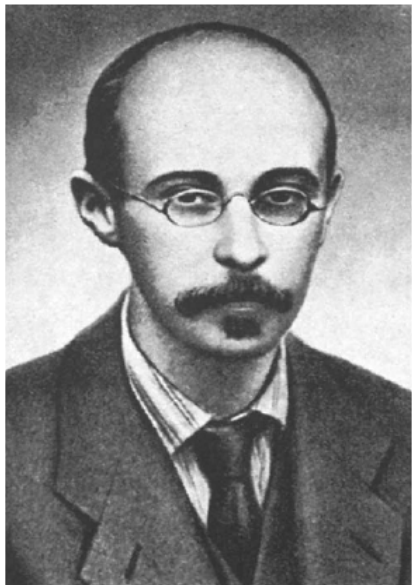
Figure 1. Alexander A. Friedmann (6 June 1988–16 September 1925), the founder of modern